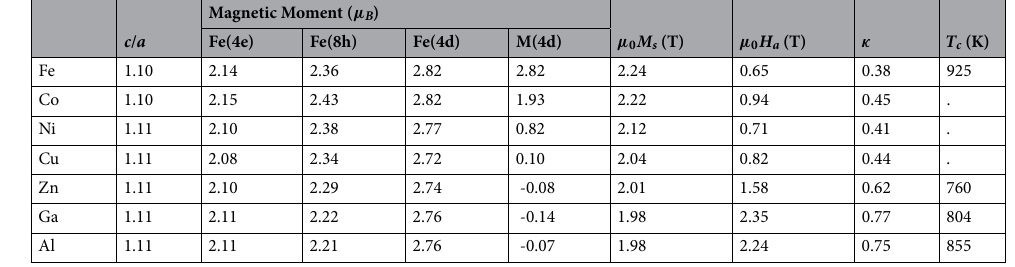
Table 1. Optimized tetragonal distortion c / a , magnetic moments ( µ B ) of Fe(4e), Fe(8h), Fe(4d), and M-replacement elements, saturation magnetization µ 0 M s (T), anisotropic field µ 0 H a (T), hardness parameter κ , and Curie temperature T c (K) of Fe 15 M 1 N 2 for M = Fe−Ga and